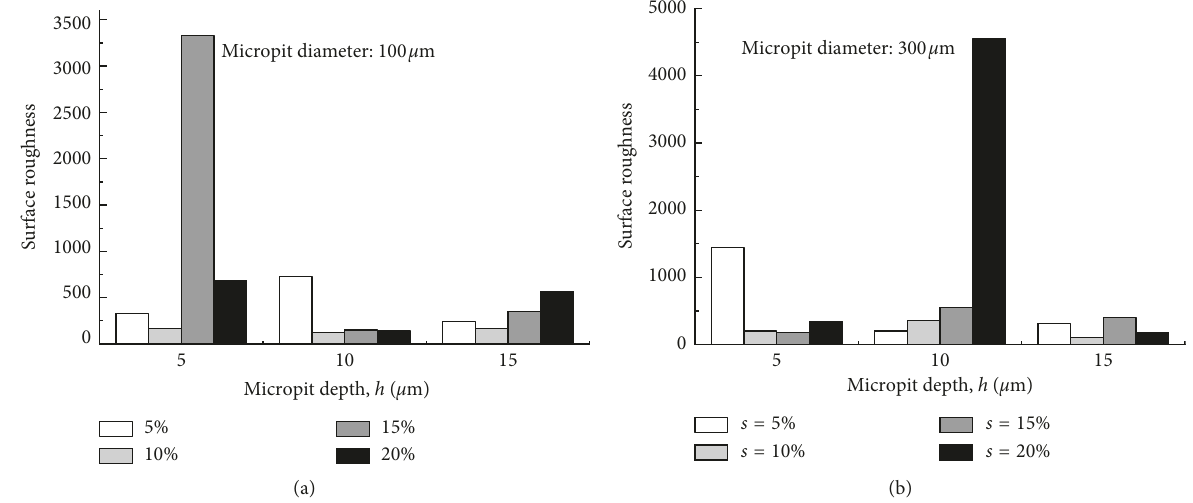
Figure 8: Relation of surface roughness and micropits’ depth. The micropit diameters of (a) 100 μ m and (b) 300 μ m.